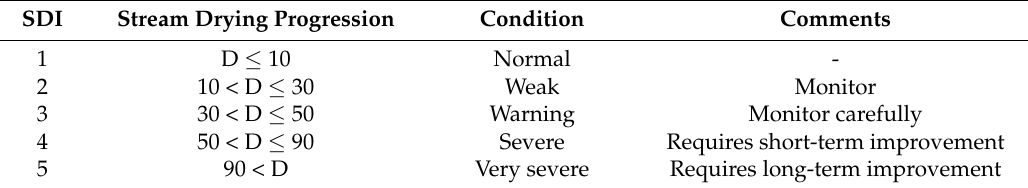
Table 1. Description of the stream drying index (SDI) for identifying